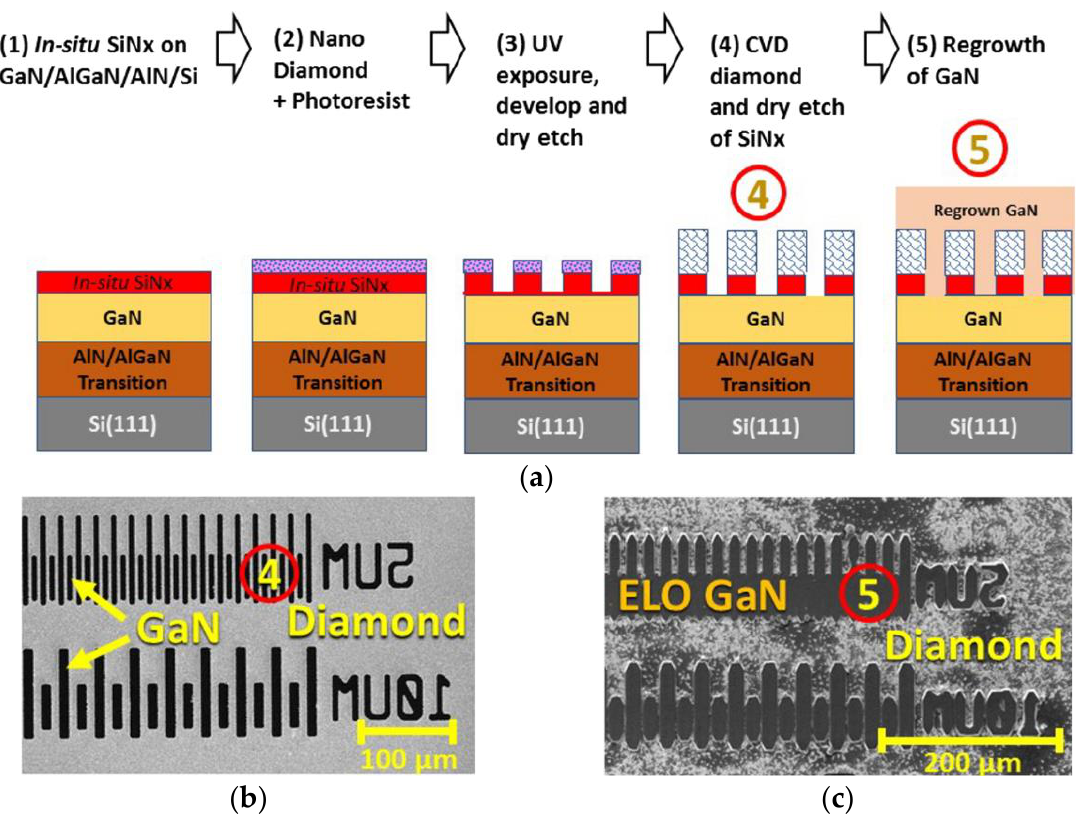
Figure 13. ( a ) Processing steps of epitaxial growth of GaN on PCD. SEM images of ( b ) selectively deposited PCD stripes (after step 4) and ( c ) same features after ELO of GaN (after step 5) (reprinted with permission from R. Ahmed et al., “Integration of GaN and Diamond Using Epitaxial Lateral Overgrowth,” ACS Appl. Mater. Interfaces, vol. 12, no. 35, pp. 39397–39404, 2020 [137]. Copyright 2020 American Chemical Society).